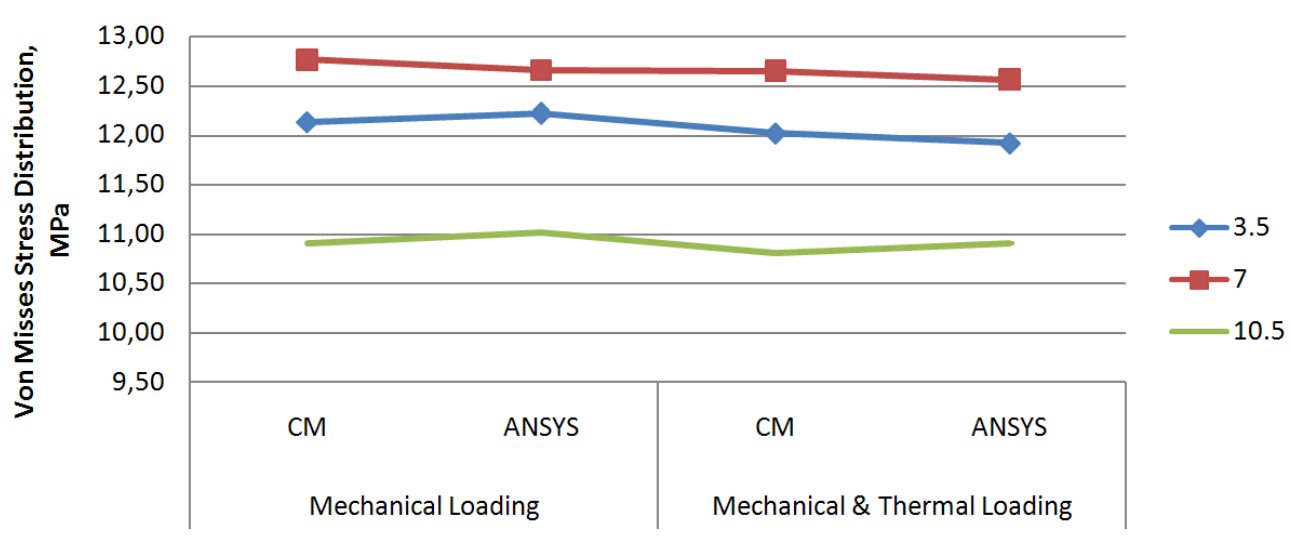
Figure 4: Comparison of maximum Von Misses stress in different